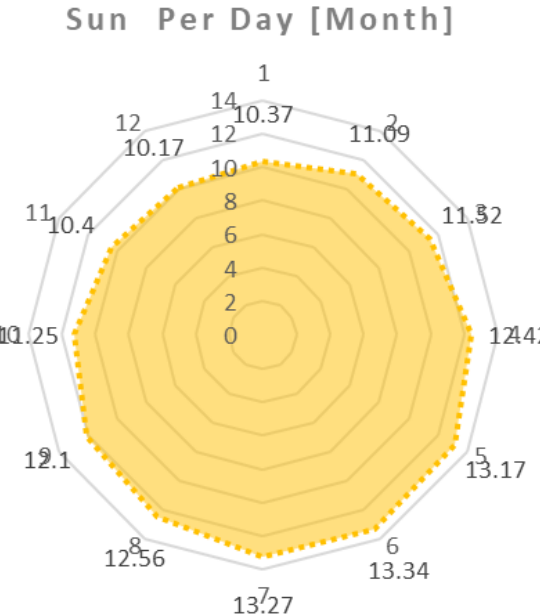
Figure 1. Average Sun Hours Per Month in Qatar .